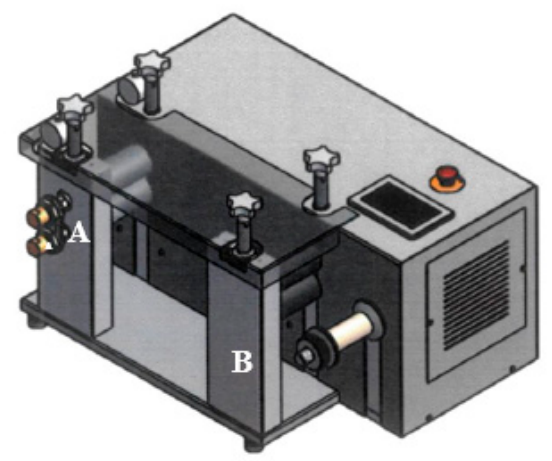
Figure 2. Plate nozzle used for plate extrusion (dimension in mm).